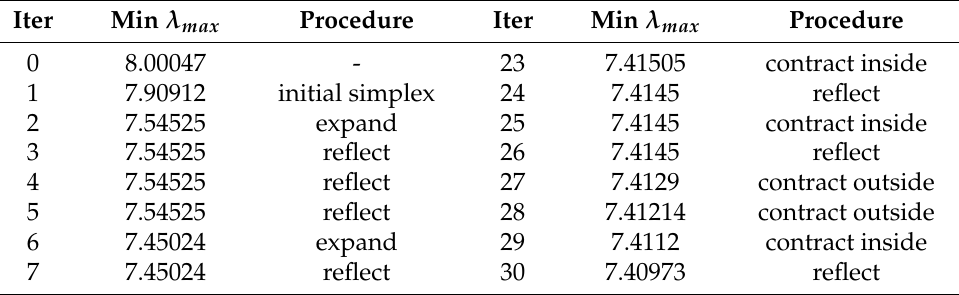
Iteration number, incumbent optimal value of λ max , and simplex procedure for minimization